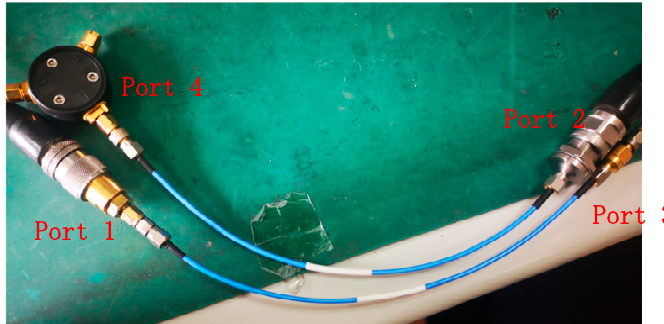
Figure 9. Photos of the measurement of the crosstalk about two adjacent coaxial lines.